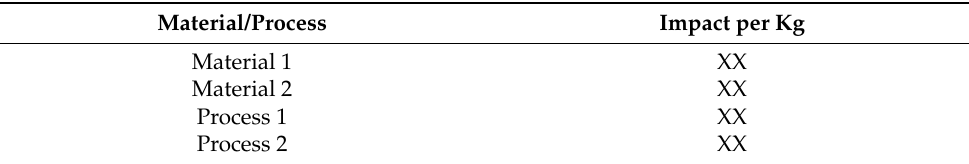
Table 1. Environmental impact of materials and processes.